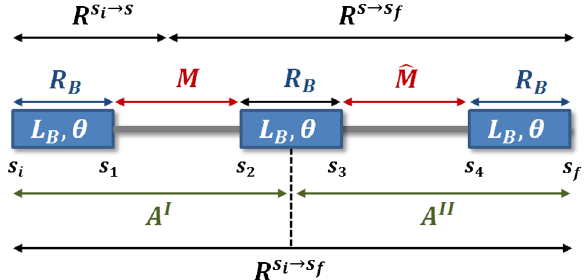
FIG. 1. Schematic of a 3-bend achromat with midpoint sym- metry consisting of three identical dipoles with L B length and θ bending angle. Indicated is our notation for the transfer matrices through specified beam line sections. The quadrupoles providing the necessary focusing between the dipoles are not